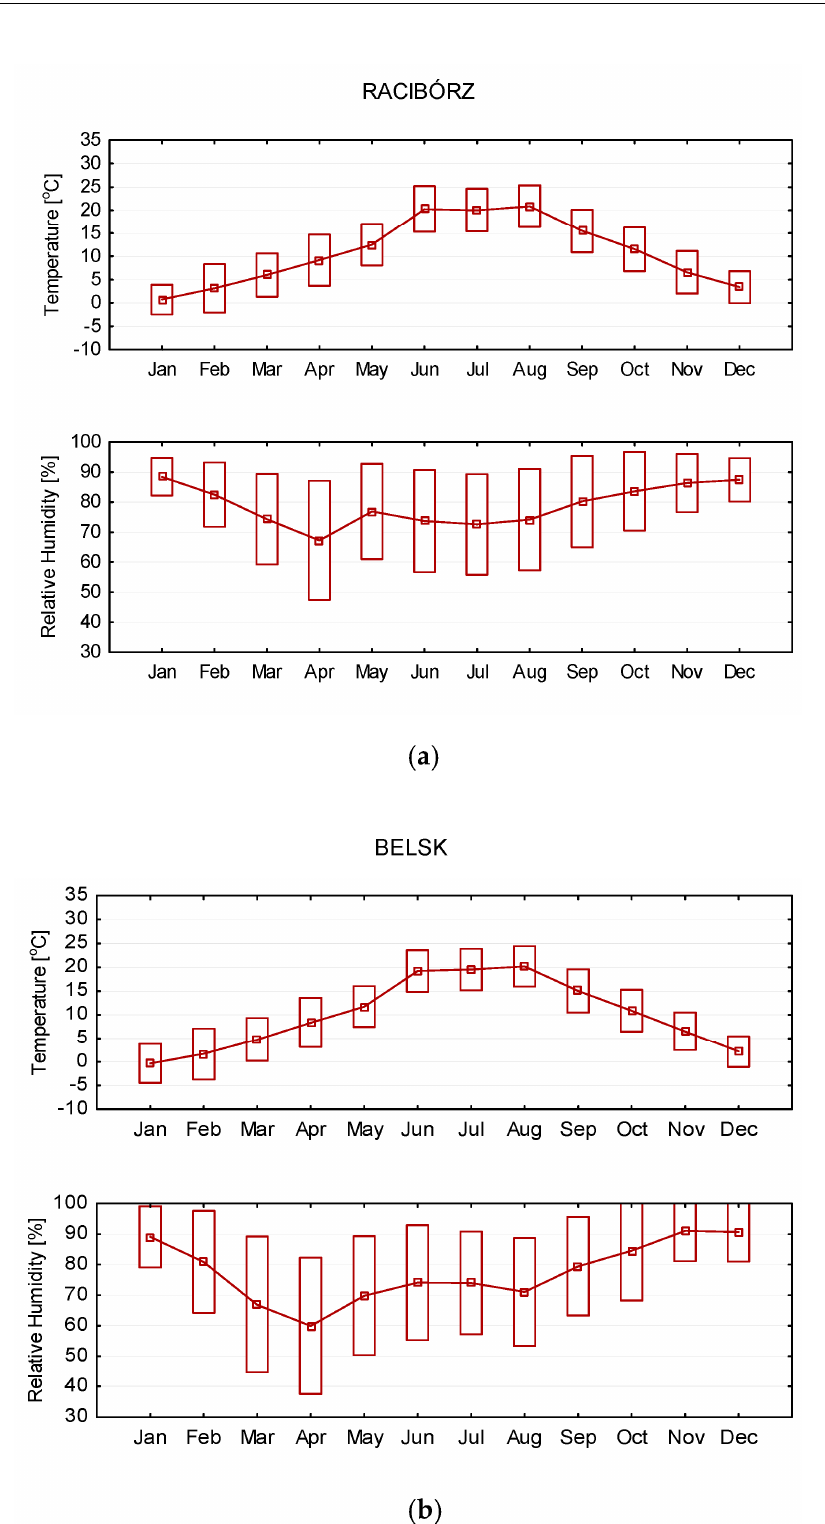
Figure 2. Monthly averaged values of temperature [°C] and relative humidity [%] in Racibórz ( a ) and Belsk ( b ) for the period 2018–2021. Points display the mean value; the box shows the range: mean ± 1 standard deviation.